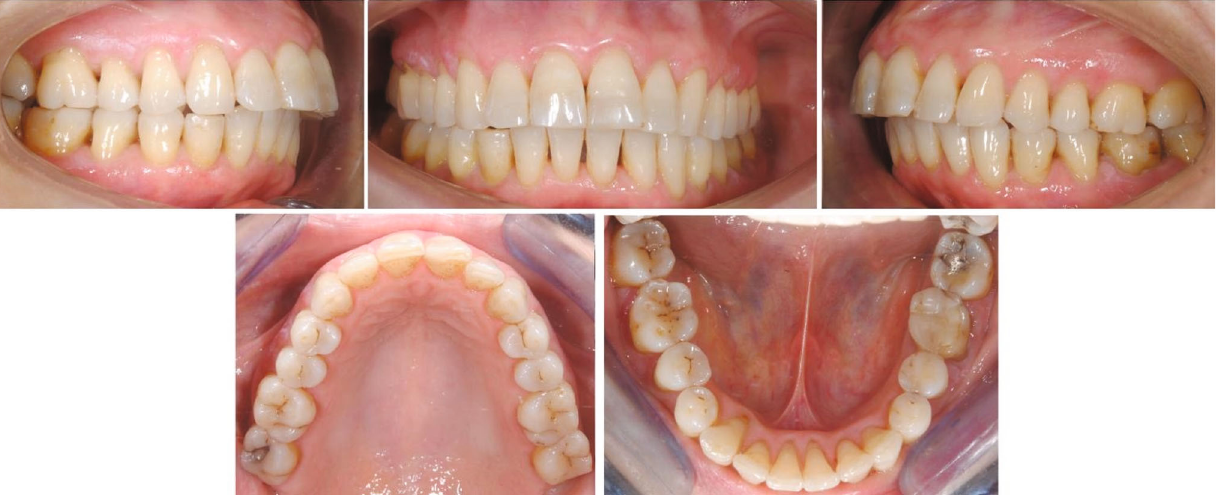
Figure 7: Final intraoral photographs.